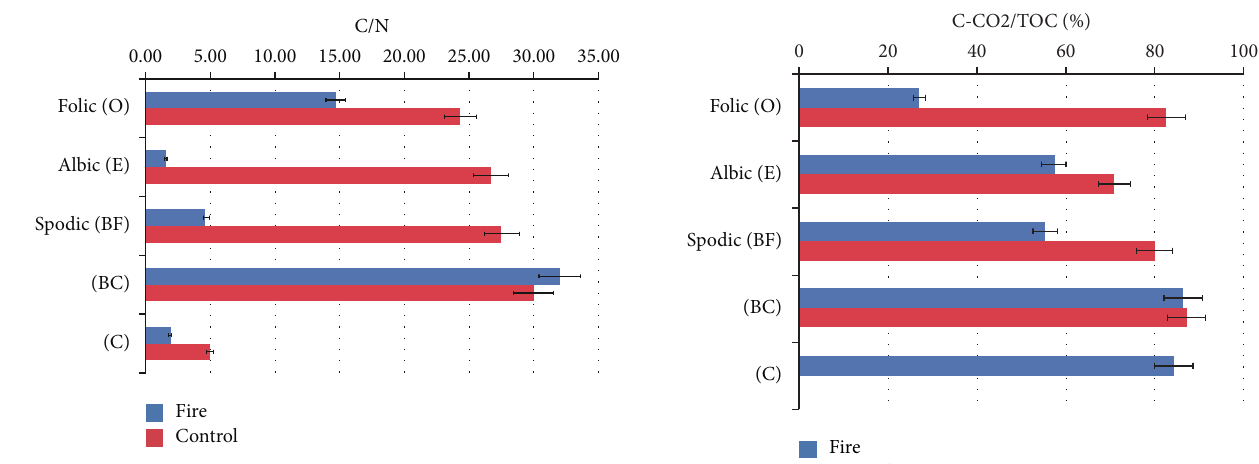
Figure 4: C/N ratio in control and fire-affected soils.